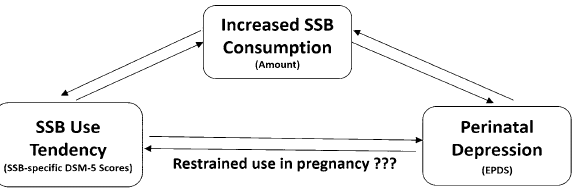
Figure 1. Hypothesized relationships among SSB use tendency, SSB intake amount and perinatal